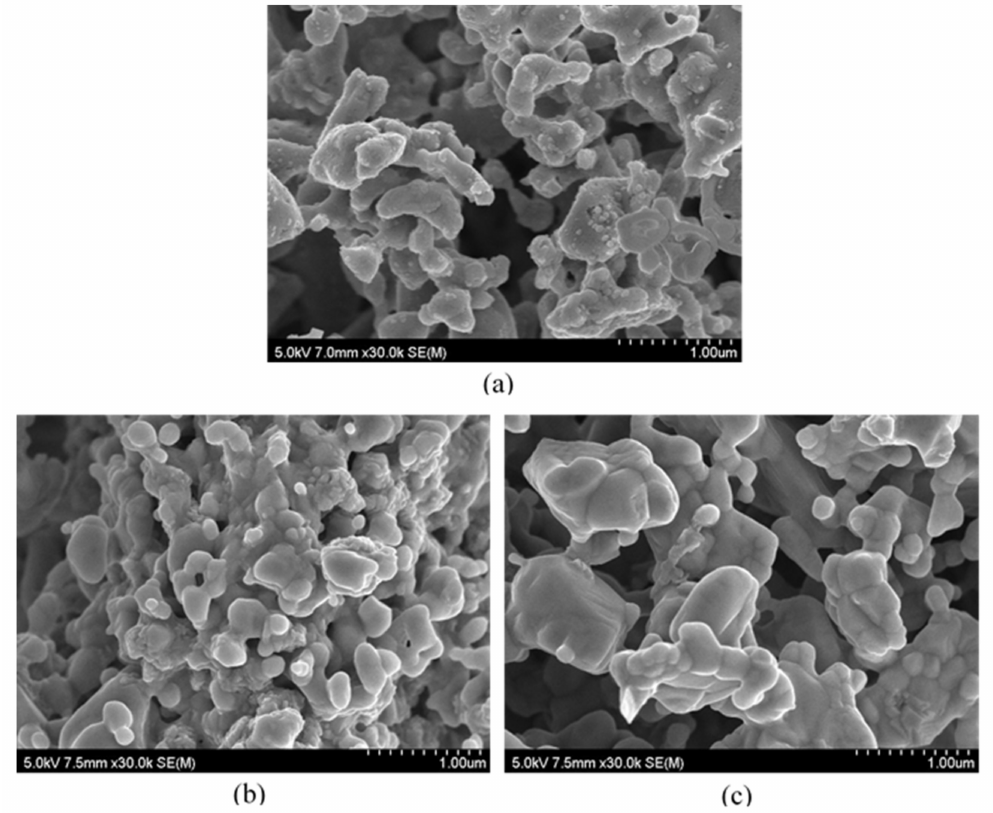
Figure 6. SEM images of SrFeO 3 − δ : ( a ) Before the redox test, ( b ) after six cycles of redox measurements at 650 ◦ C, and ( c ) after five cycles of reproducibility tests at 700 ◦